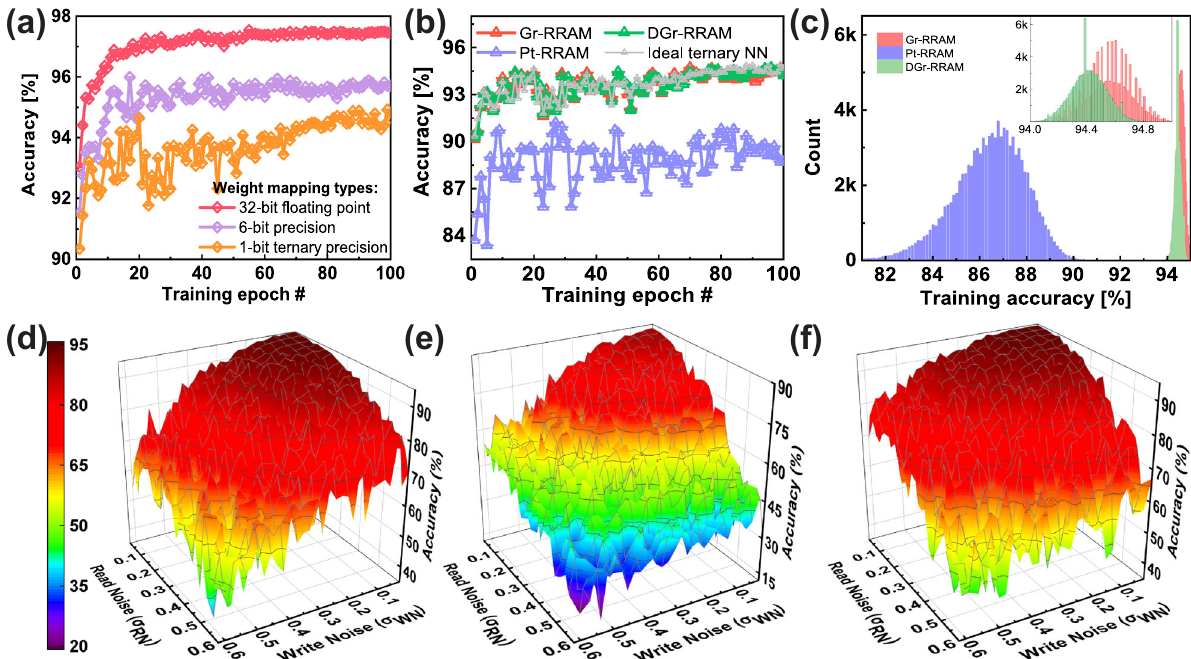
Fig. 7 The training accuracy of VRRAM array-based neural network estimated through simulation. a Evolution of the training accuracy according to the epoch for neural network (NN) models, including weights with original 32-bit fl oating-point precision, 6-bit precision (for 64 distinctive conductance states in a multilevel cell), and 1-bit ternary precision. b Evolution of the accuracy in the NN model with ternary synaptic precision with an injected worst-case scenario of the read inaccuracy values corresponding to the Pt-, Gr- and DGr-RRAM arrays in the inference process. c Accuracy distribution from 100,000 MC simulation runs. Inset: magni fi ed plot for Gr- and DGr-RRAM arrays. Due to high read inaccuracy in Pt-RRAM, the overall accuracy levels degrade signi fi cantly. Comparing Gr- and DGr-RRAM, some random inaccuracies can, to a certain extent, be favorable during the inference operation. The effect of read and write noise (including cycle-to-cycle and device-to- device variations) on the recognition accuracy for d Gr-RRAM, e Pt-RRAM, and f DGr-RRAM